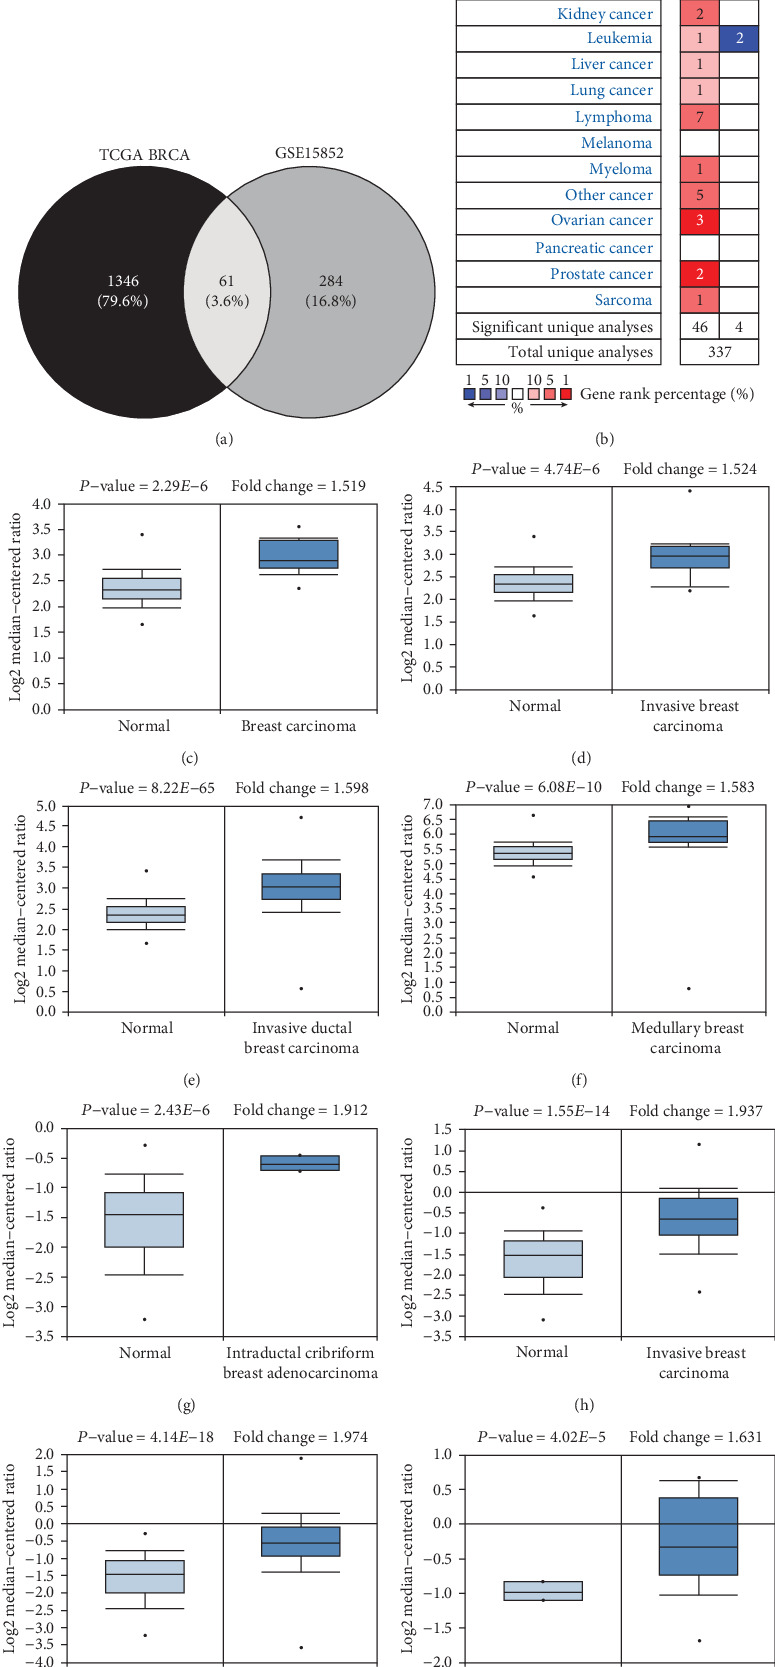
Upregulation of HNRNPAB in BC tissues. (a) Venn diagram of commonly upregulated HNRNPs in TCGA-BRCA and GSE15852. HNRNPAB was identified as the only overexpressed HNRNP in BC tissues compared to noncancerous tissues. (b) HNRNPAB was significantly upregulated in various malignancies including BC. (c-j) Box plots comparing the HNRNPAB mRNA level in normal tissues (left) and BC tissues (right) were generated from the Oncomine database. (k) HNRNPAB was amplified or upregulated in 6% of BC cases.